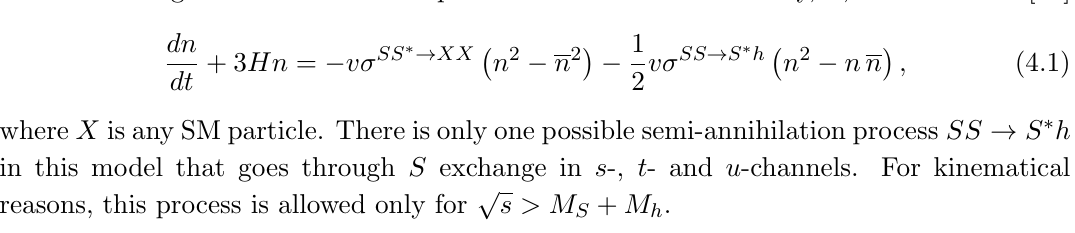
Figure 1 . Constraints on the parameter space. In the blue area, the EW-breaking, Z vacuum is not stable (is metastable for light blue). Yellow marks lack of perturbativity and magenta violation of perturbative unitarity. The vertical magenta line marks the bound on unitarity in the limit s . The white area is allowed by all ! 1